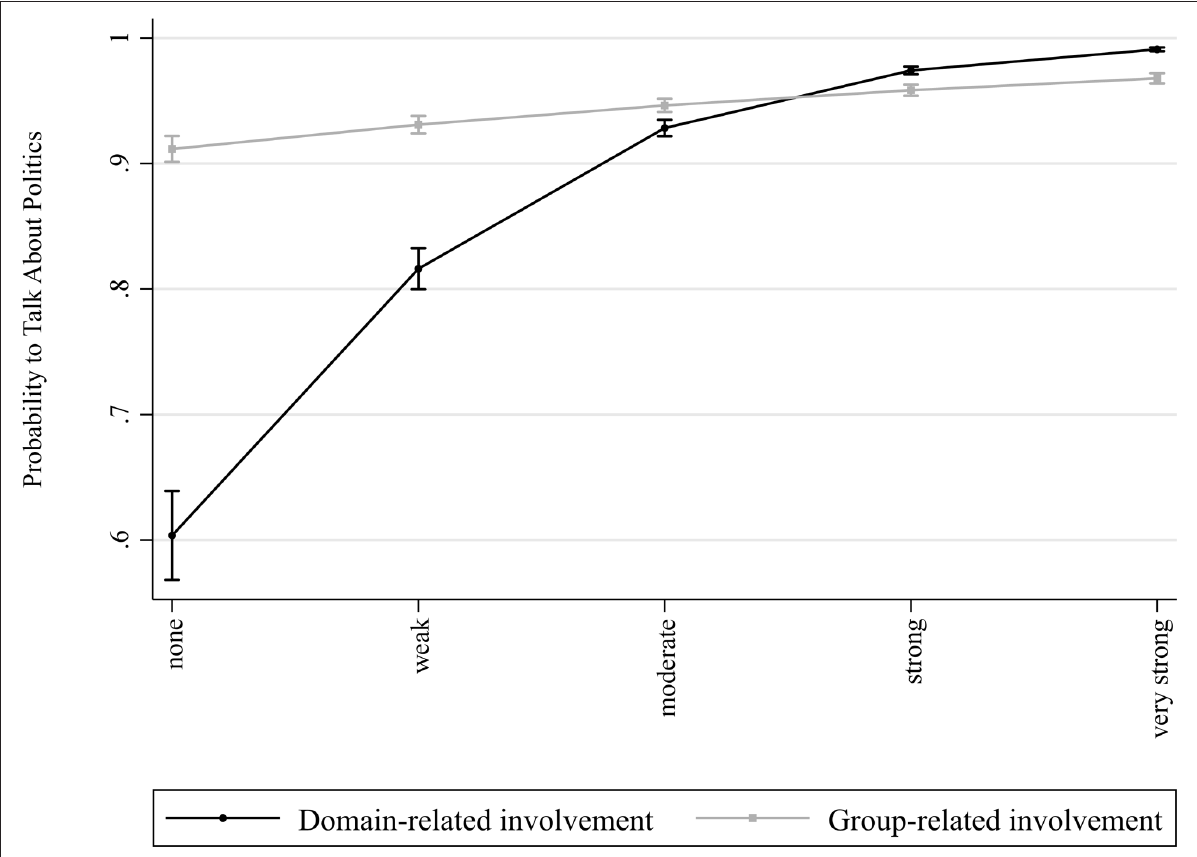
Figure 2: Predicted participation in political talk by levels of political